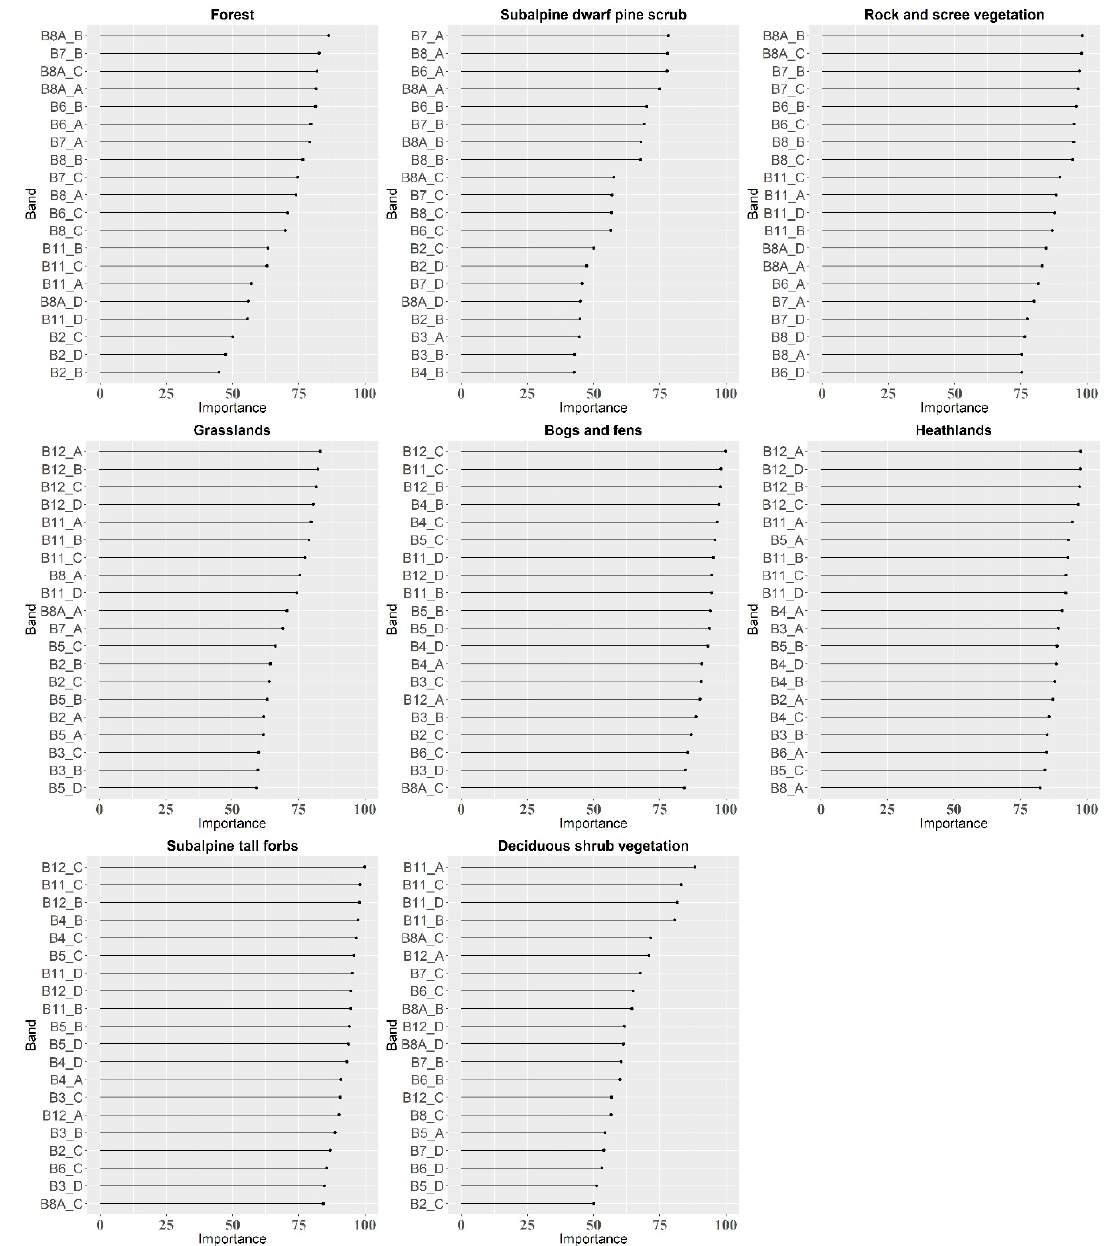
Figure A2. The 20 most important variables in classification of each vegetation type using ABCD dataset.